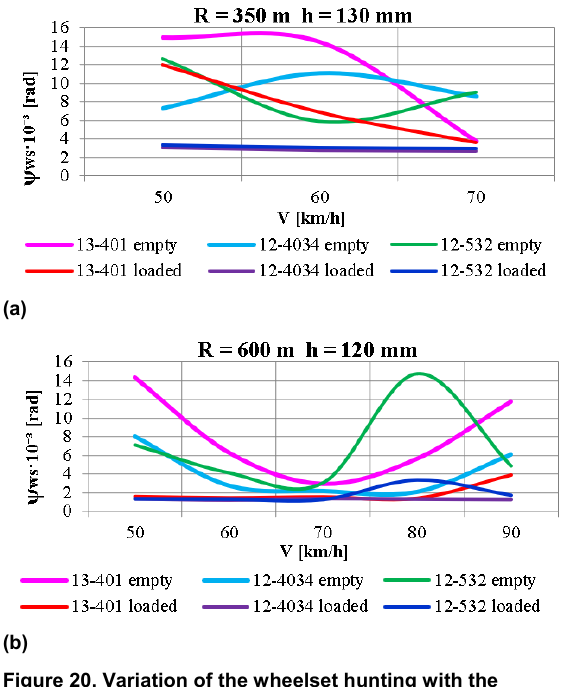
Figure 20. Variation of the wheelset hunting with the motion speed: (a) R=350 m curve; (b) R=600 m curve The speed of 80 km/h is considered critical for open wagons on bogies 18-100 and is associated with a